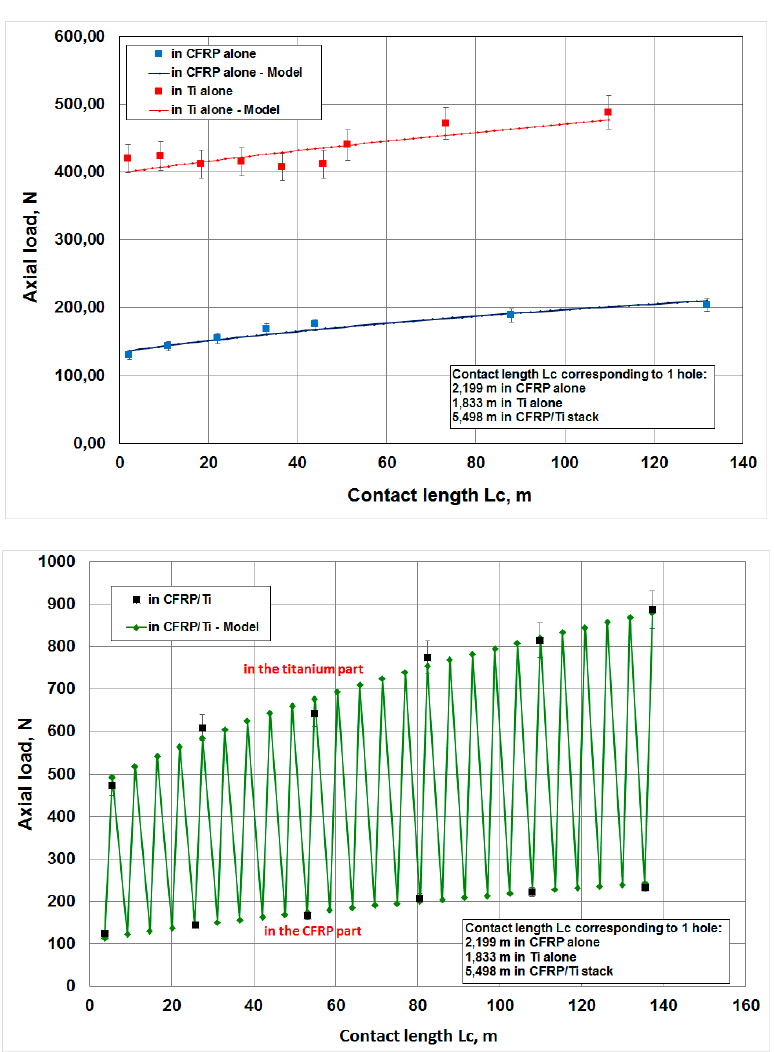
Figure 22. Evolution of tool wear in the different configuration and assuming for CFRP/Ti alloy stacks that 90% of the wear is produced in the CFRP and 10% in the Ti alloy.